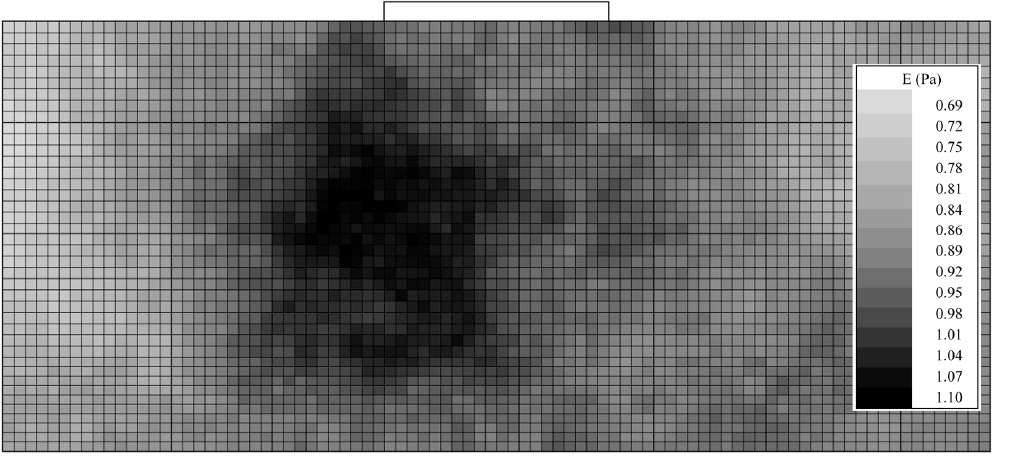
Figure 13. Graphical representation of the random field of E of Example #4 ( θ / B = 50; see Table 1). Table 1. Summary of the characteristics of the soils used in the four examples (footing width B = 1 m).